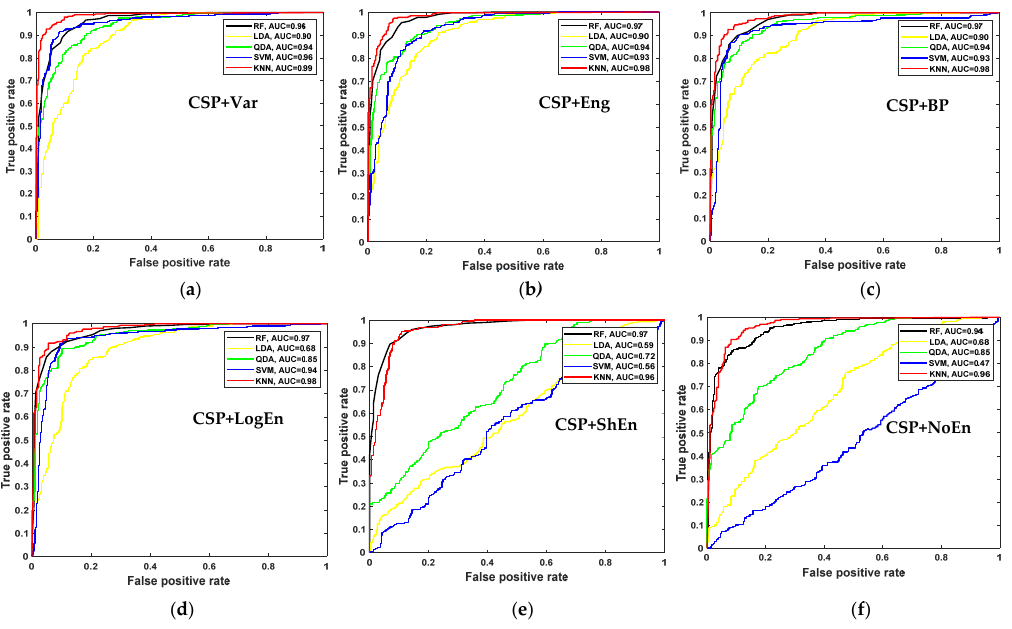
Figure 6. ROC and AUC of off–PD vs. HC classification based on features extracted from ( a ) CSP+Var, ( b ) CSP+Eng, ( c ) CSP+BP, ( d ) CSP+LogEn, ( e ) CSP+ShEn and ( f ) CSP+NoEn. Investigation of Frequency Bands